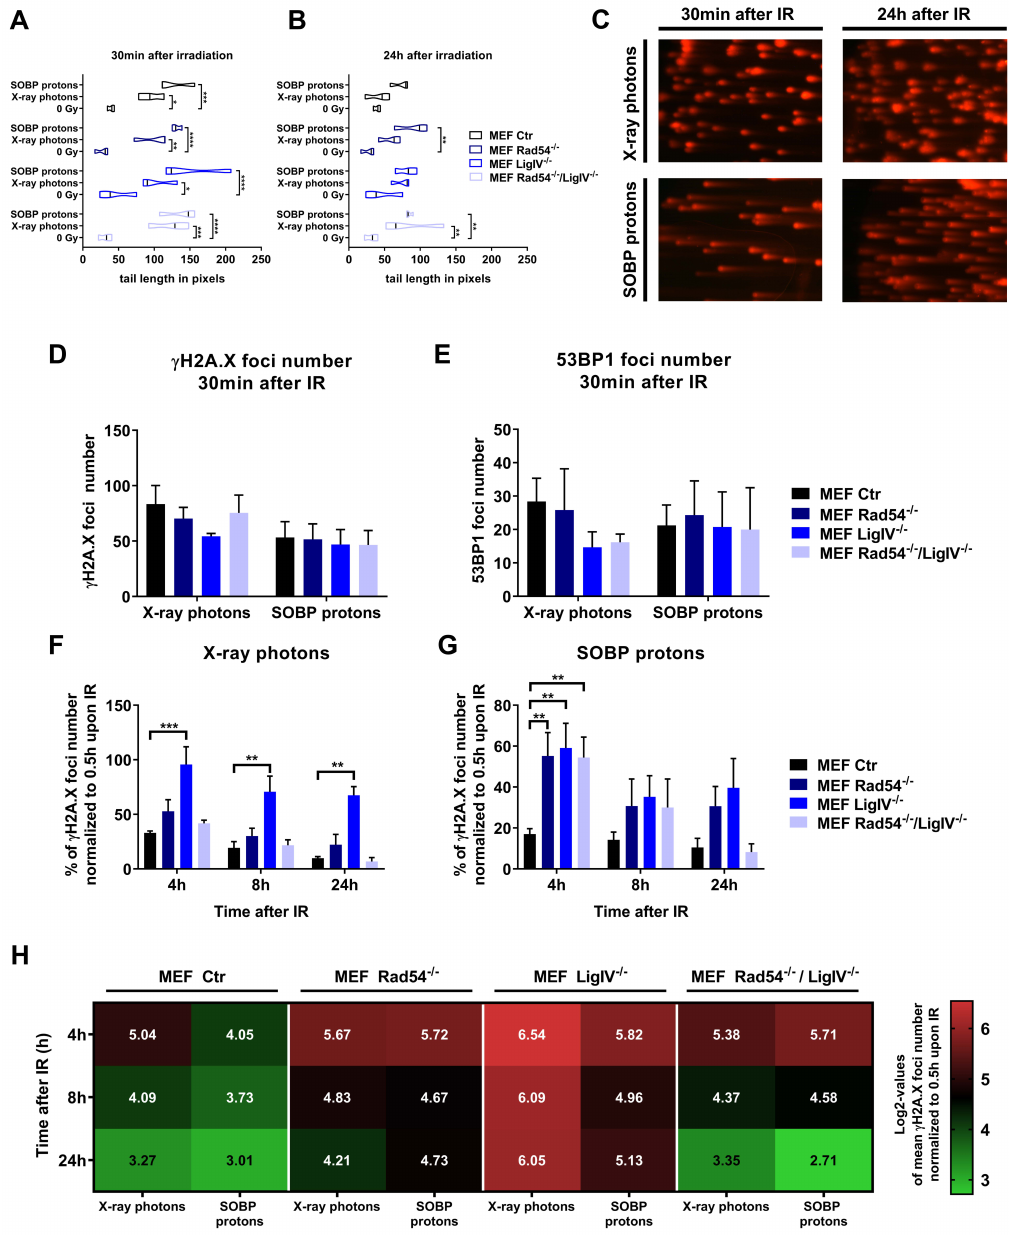
Figure 3. DNA damage repair induced by X-ray photons or SOBP protons in MEFs. ( A , B ) Quantification of alkaline comet assay in wild type (Ctr), Lig IV-deficient (Lig IV − / − ), Rad54-deficient (Rad54 − / − ) or Lig IV / Rad54 double-deficient MEFs (Rad54 − / − / Lig IV − / − ) at 30 min ( A ) and 24 h ( B ) after irradiation with 3 Gy of X-ray photons or SOBP protons. ( C ) Exemplary pictures of alkaline Comet assay of wild type MEFs (MEF ctr) 30 min or 24 h after X-ray photon or SOBP proton irradiation. ( D ) γ H2A.X and ( E ) 53BP1 foci number 30 min after irradiation with 3 Gy of X-ray photons and SOBP protons. ( F , G ) Quantification of DNA repair kinetics of MEFs harboring deficiencies in Rad54, Lig IV or Rad54 and Lig IV determined by quantification of γ H2A.X foci. Data represent values normalized to 30 min after irradiation with 3 Gy. ( H ) Comparison of radiation source e ff ects in tested cell lines as log2 values of γ H2A.X foci quantification. Data represent mean SEM from three independent experiments. Two-way ANOVA with Tukey’s multiple comparisons post-test; * p < 0.05; ** p < 0.01; *** p < 0.001; **** p <